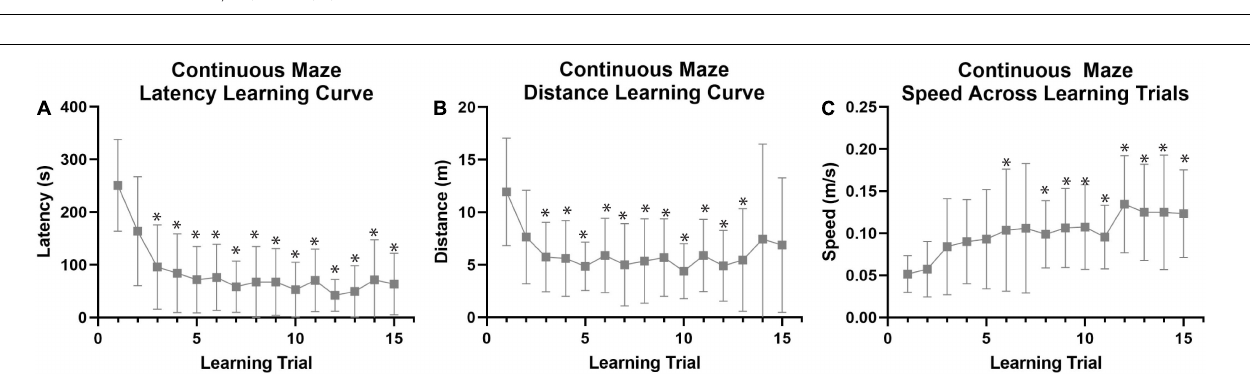
FIGURE 4 | Non-continuous spatial maze learning performance in naked mole-rats. Preliminary data were collected ( n = 8) using a non-continuous modified version of the Hebb-Williams maze (see Figure 1A ) to investigate spatial learning and memory capabilities in naked mole-rats across 15 training trials (5 trials per day for 3 days). (A) Latency to reach the reward chamber was averaged across animals for each of the training/learning trials. Non-continuous maze performance exhibited a very gradual latency learning curve with a trend toward decreased latency across trials but large variability in individual performance. (B) The average number of entries into an error zone was plotted for all animals tested across the training/learning trials. No error reduction learning curve was present for the non-continuous maze. (C) Total distance traveled prior to reaching the reward chamber was averaged across animals for each trial and plotted for all training/learning trials. Non-continuous maze performance exhibited large variability in individual performance and no learning curve related to decreases in distance traveled (optimizing route to the reward chamber). m, meters; s, seconds.